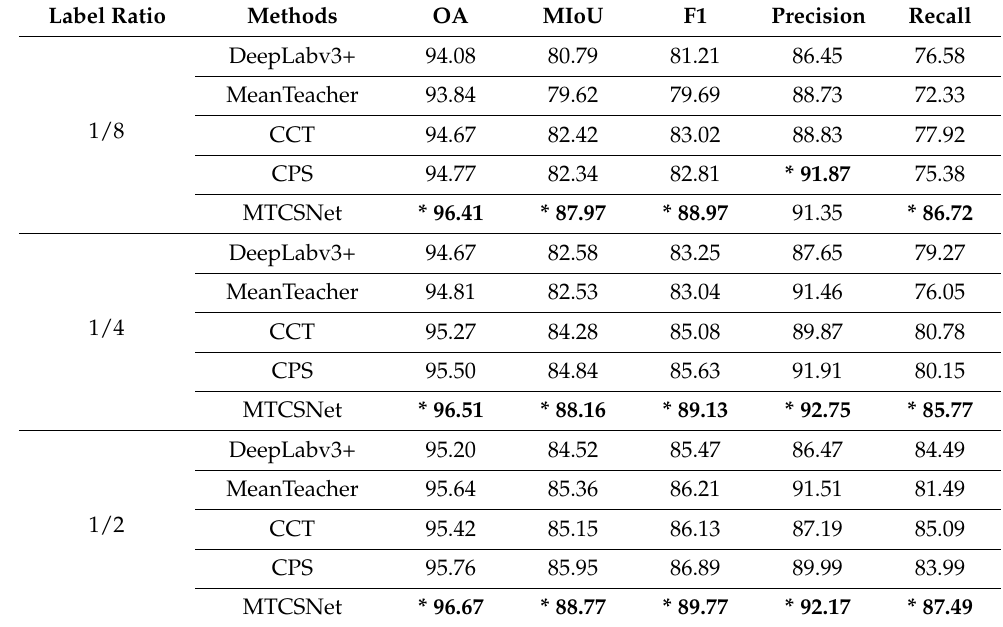
Table 5. Quantitative performance comparison on the SPARCS